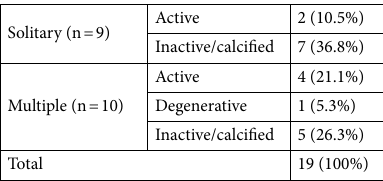
Table 2. CT scan features of active epilepsy patients with neurocysticercosis. CT findings classified into three groups as suggested by Carpio and